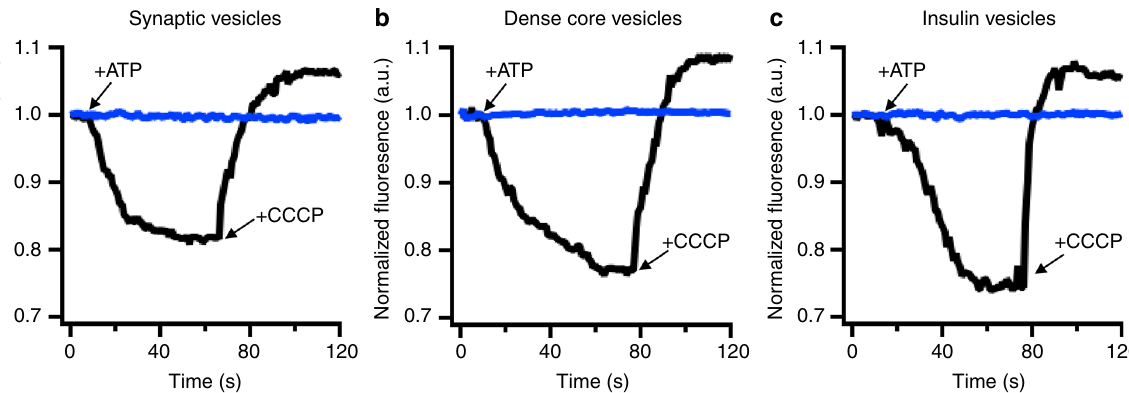
Fig. 2 Puri fi ed secretory vesicles contain functional V-ATPase acidi fi cation of a synaptic vesicles, b dense-core vesicles, or c insulin vesicles. Bulk acridine orange fl uorescence was monitored in the presence of the secretory vesicle and valinomycin (black line). Addition of ATP drives progressive self- quenching of the acridine orange fl uorescence due to concentration into the interior of the secretory vesicle. The addition of CCCP dissipates the pH gradient causing an increase in acridine orange fl uorescence. The presence of ba fi lomycin inhibits the proton pump preventing the acidi fi cation of